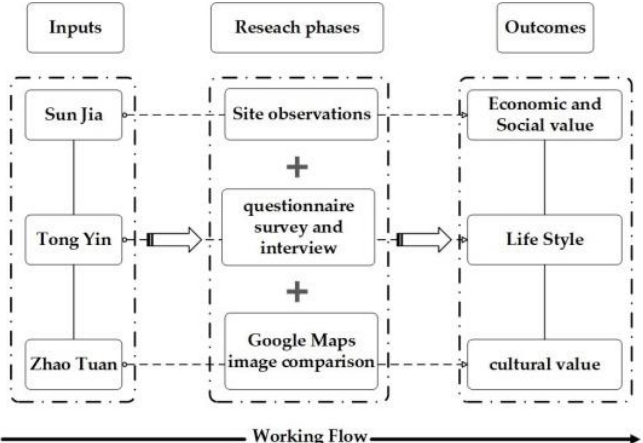
Figure 2. Research framework (Source: Own drawing).